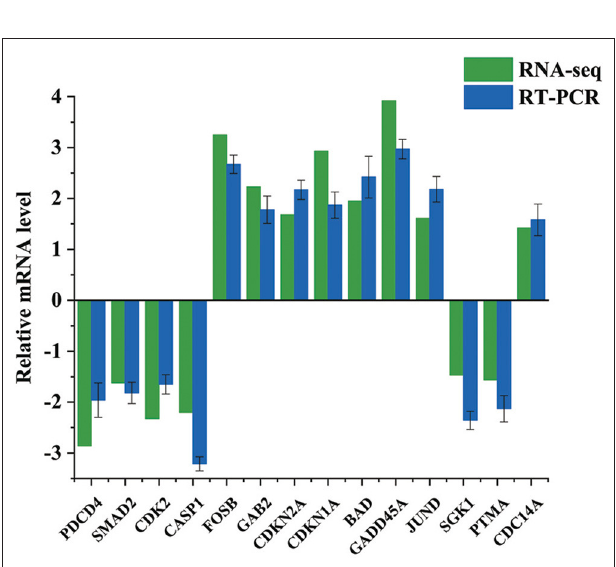
FIGURE 4 | Validation of the DEGs by qRT-PCR. Bars show the relative expression level of DEGs. All the values were log2 transformed.